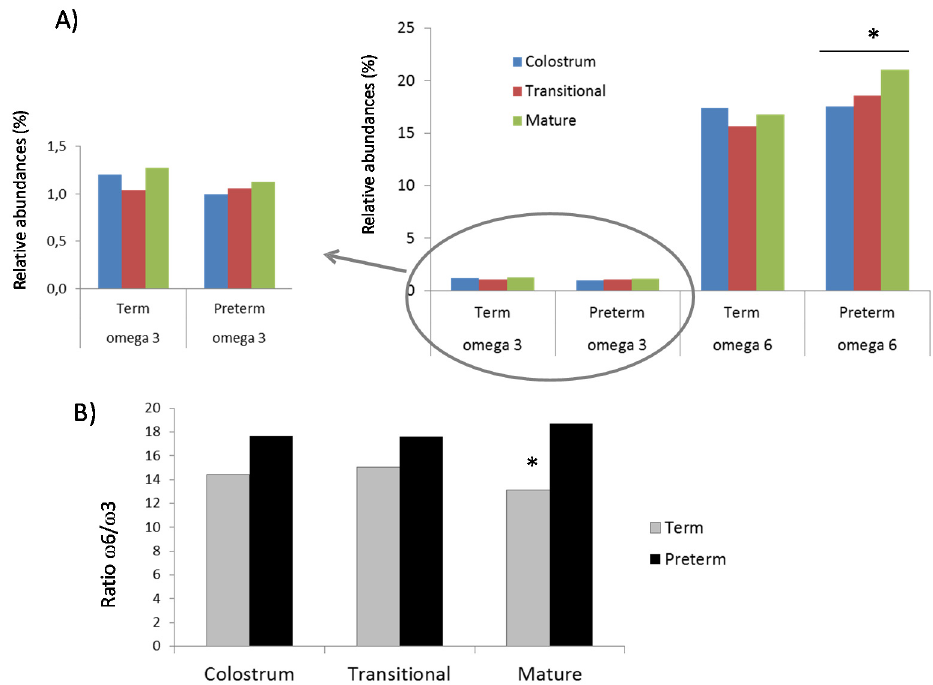
Figure 2. Relative abundances of unsaturated fatty acids (Panel A) and ratio omega ‐ 6 to omega ‐ 3 (Panel B) in breast milk samples. The ratio omega ‐ 6 to omega ‐ 3 was significantly different (* p ‐ value < 0.05) between term and preterm samples.